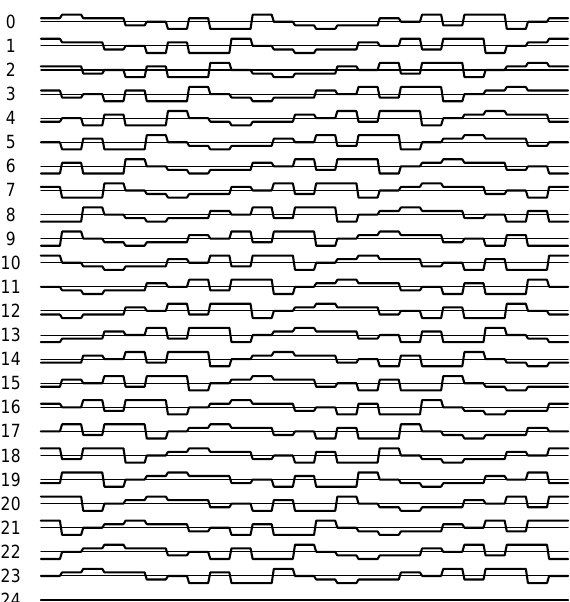
Fig. 2. The phases of a 25 baud 5-nary alternating code. The cyclic nature of the code set is evident. One can also see property 2, which implies that each code is conjugate